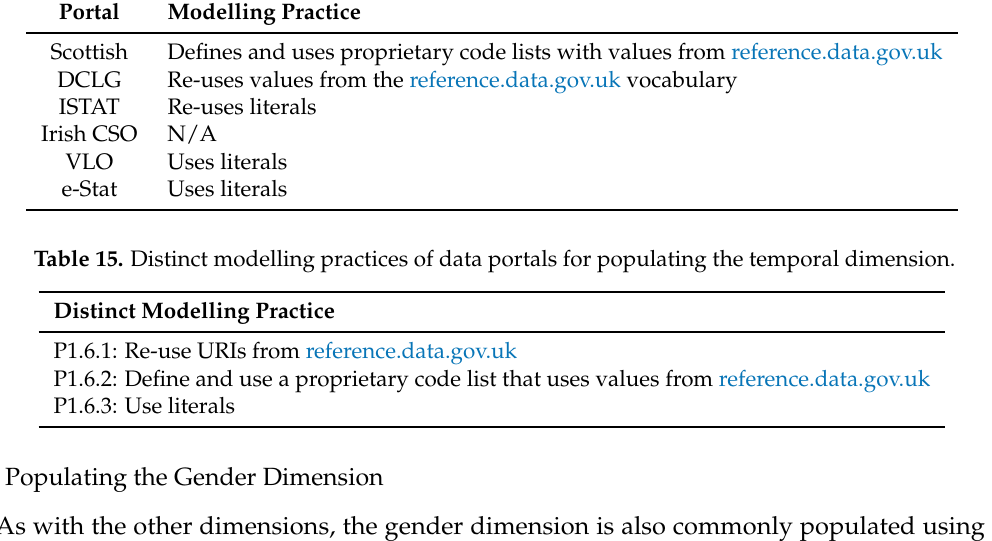
Table 14. Modelling practices of data portals for populating the temporal dimension. Portal